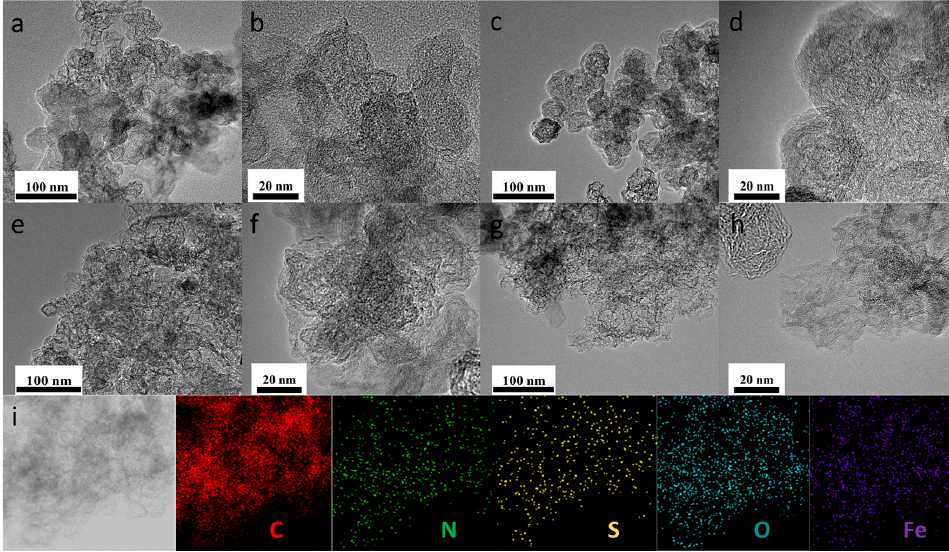
Figure 4. Transmission electron microscope (TEM) images of ( a , b ) Fe/NS/C ‐ g ‐ C 3 N 4 /TPTZ; ( c , d ) Fe/NS/C ‐ g ‐ C 3 N 4 /TPTZ ‐ 800; ( e , f ) Fe/NS/C ‐ g ‐ C 3 N 4 /TPTZ ‐ 900; ( g , h ) Fe/NS/C ‐ g ‐ C 3 N 4 /TPTZ ‐ 1000; and ( i ) TEM ‐ EDX (EDX: energy dispersive X ‐ ray spectroscopy) mapping analysis of C, N, S, O, and Fe of Fe/NS/C ‐ g ‐ C 3 N 4 /TPTZ ‐ 1000.